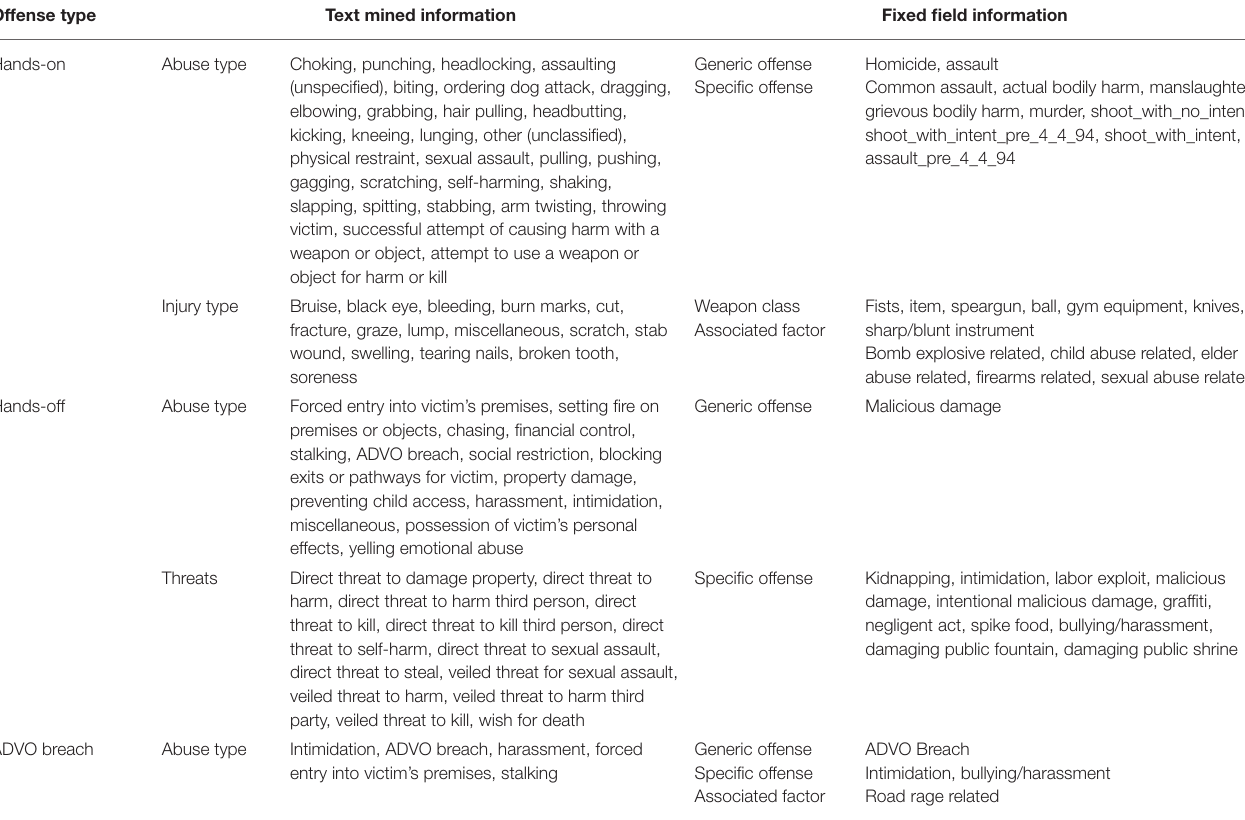
TABLE 1 | The selected features that represent the “hands-on,” “hands-off” and “ADVO breach” offenses from the text mined information and fixed fields. Offense